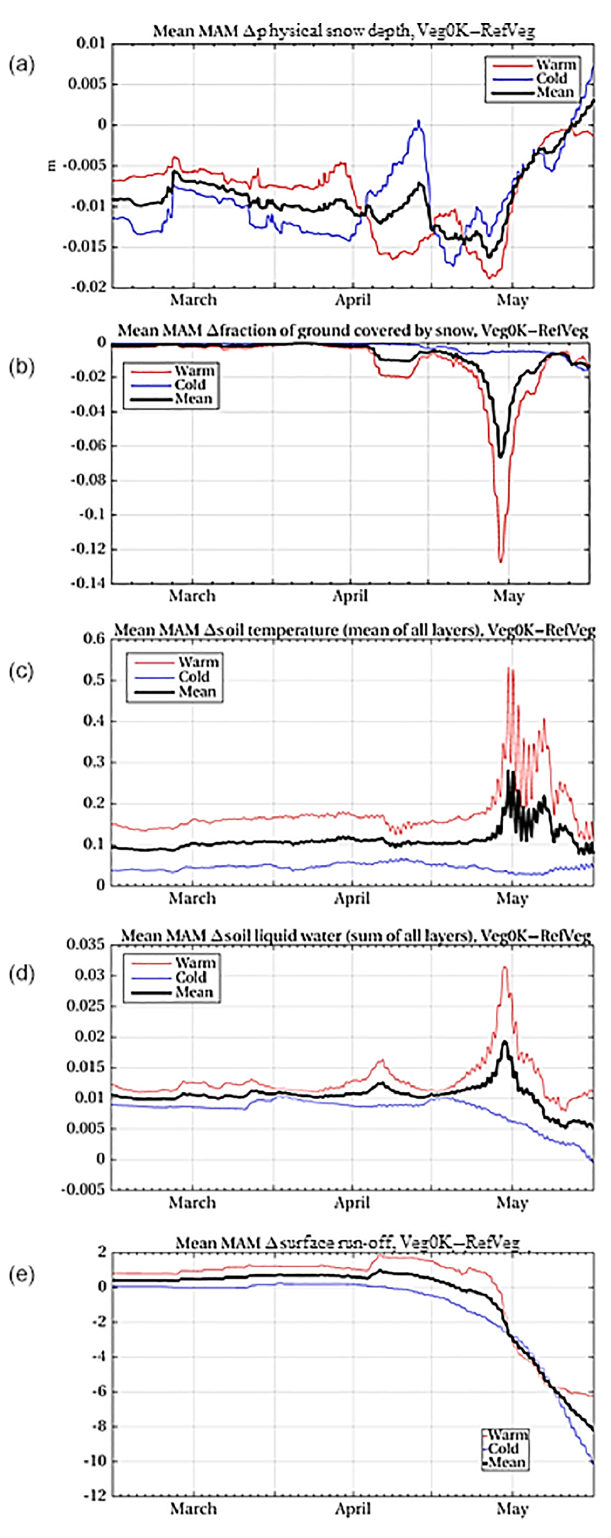
Figure 9. Effect of increased shrub cover (Veg0K–RefVeg) on spring snow depth and cover, soil temperatures, and moisture con- tent and surface run-off, as averaged over all areas with vegeta- tion changes. Red and blue lines indicate warm and cold season response, respectively. Black lines indicate inter-seasonal